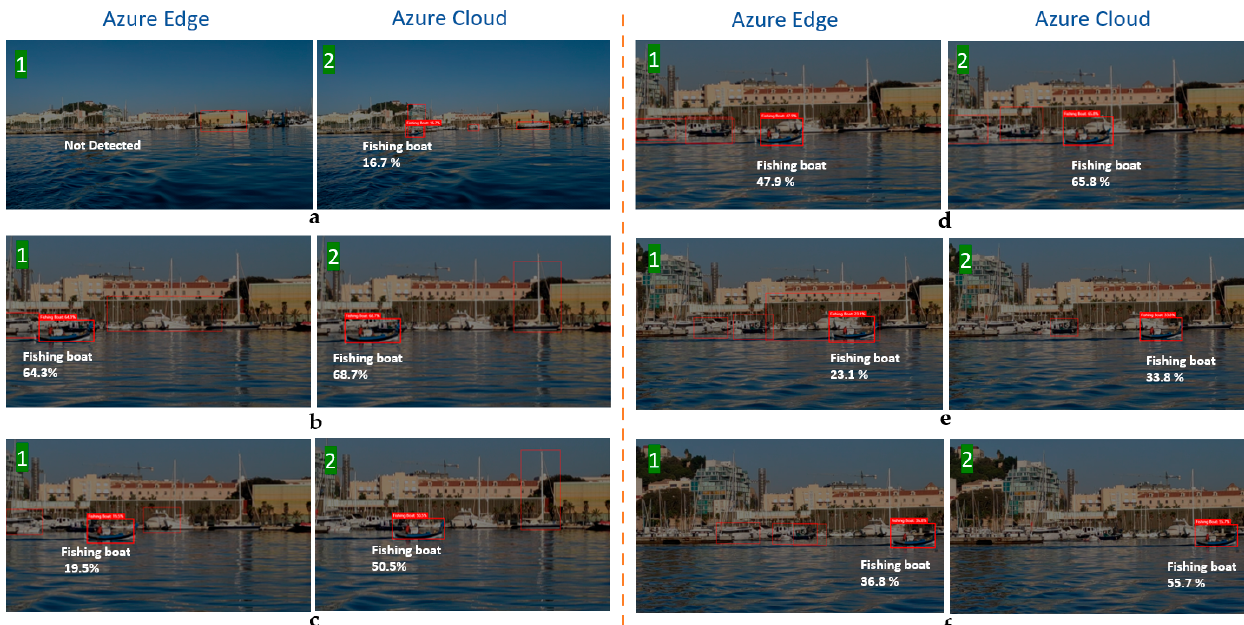
Figure 13. Cloud/edge results comparison of a fishing boat in different positions.